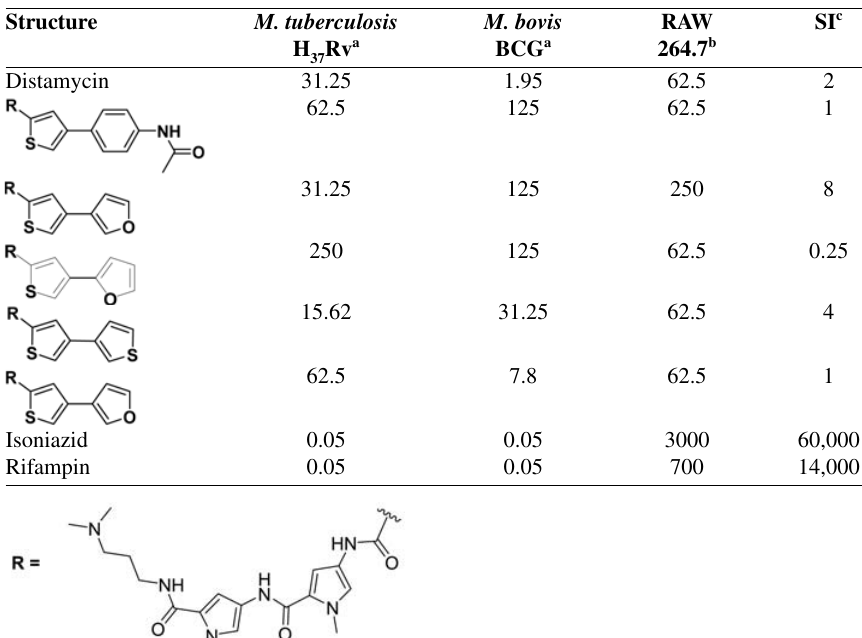
Table 4: Representative examples of the biological activity screening results 33